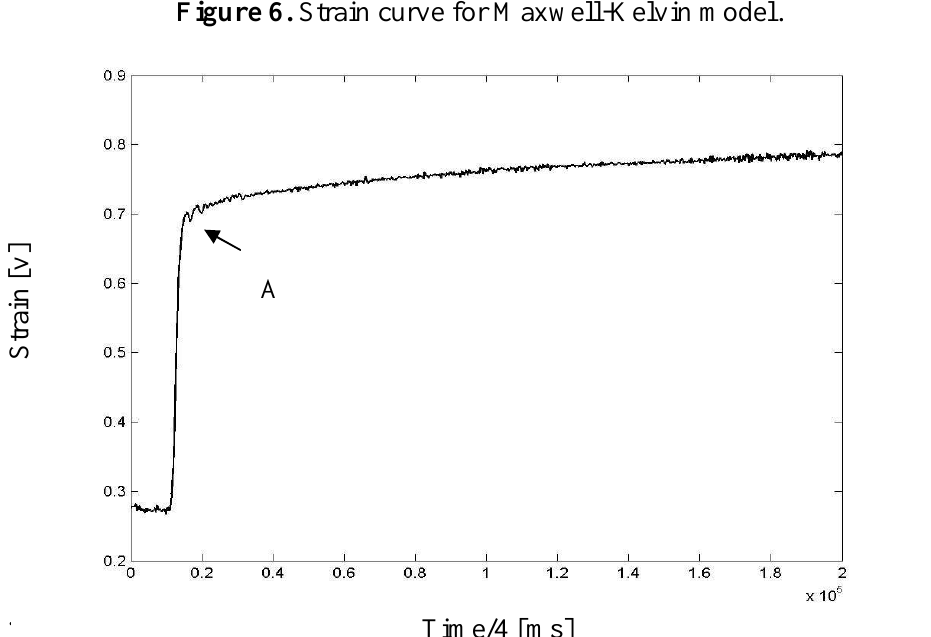
Figure 7. Response of the sensor after a force